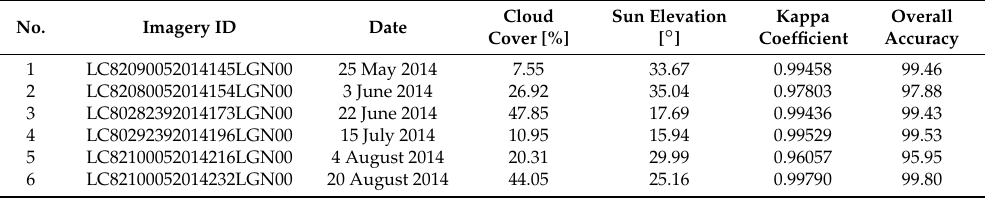
Table 4. Basic characteristics of used Landsat 8 images and supervised classification